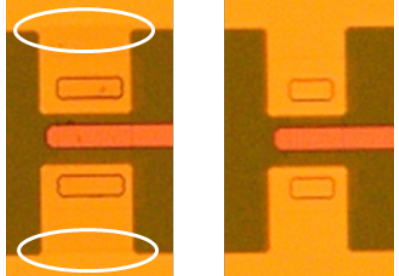
Figure 11: Microscope image of a transistor that is lasered (left) and a transistor that is not lasered